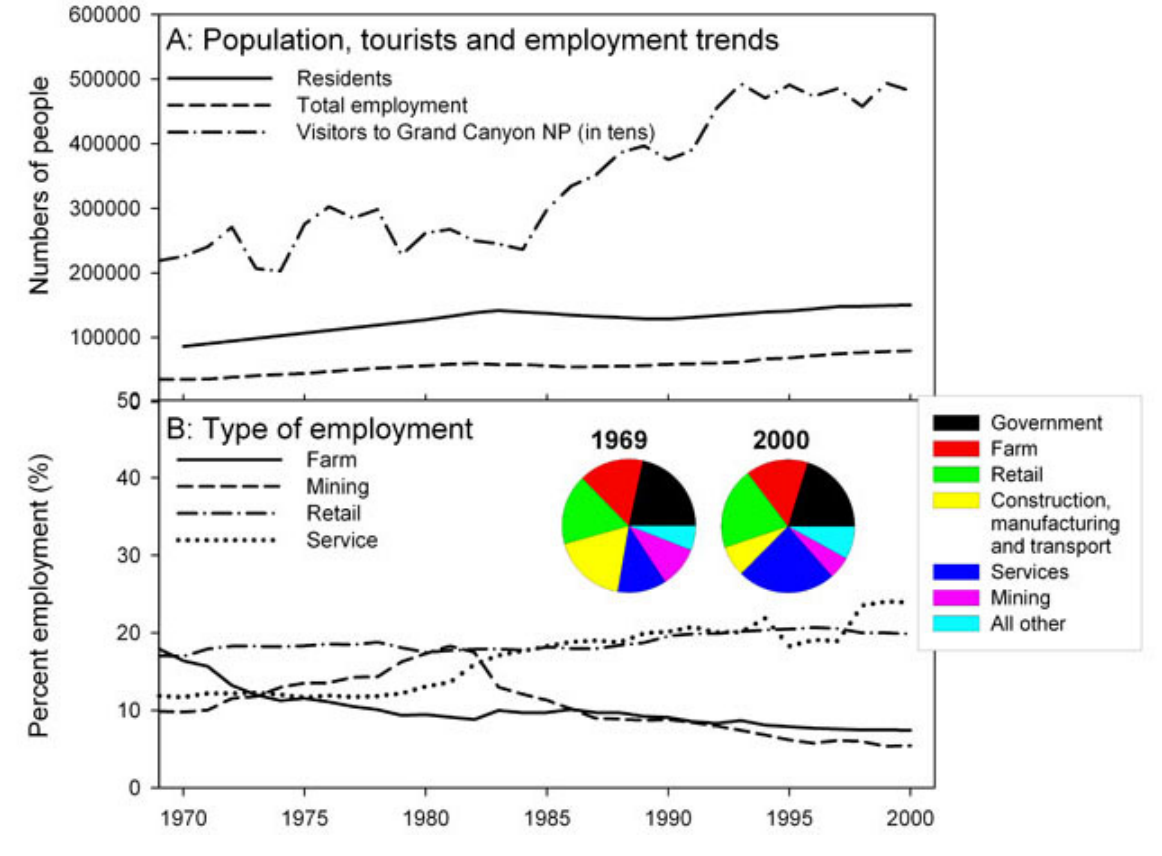
Fig. 6. A: population, employment, and tourism trends on the Colorado Plateau. B: Employment trends by sector. (Data sources: U.S. Department of Commerce, Bureau of Economic Analysis and National Park